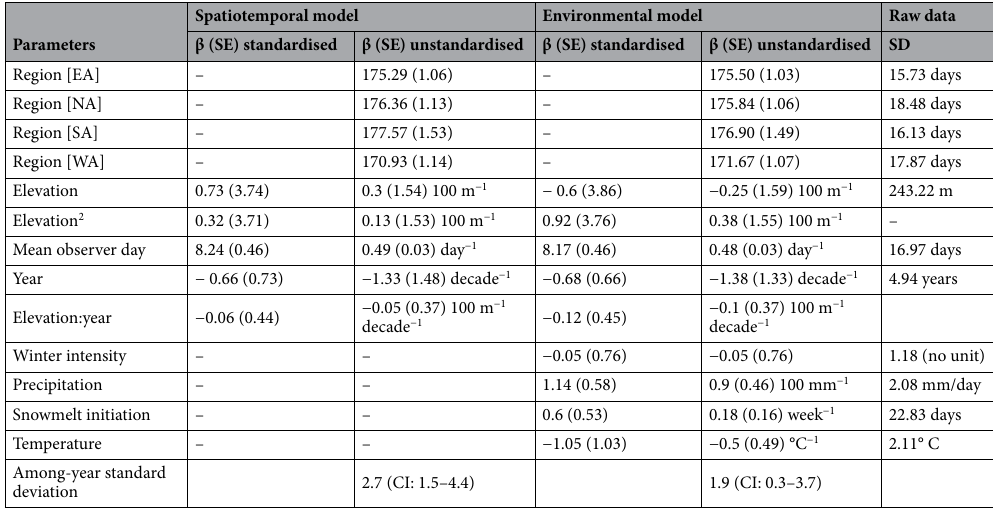
Table 1. Standardised and unstandardised parameters for the spatiotemporal and environmental model including Bayesian compatibility intervals and standard deviations. Unstandardised parameters show change in hatching date per unit of the predictor. Winter intensity has no unit because it is measured as a principal component of temperature and precipitation.